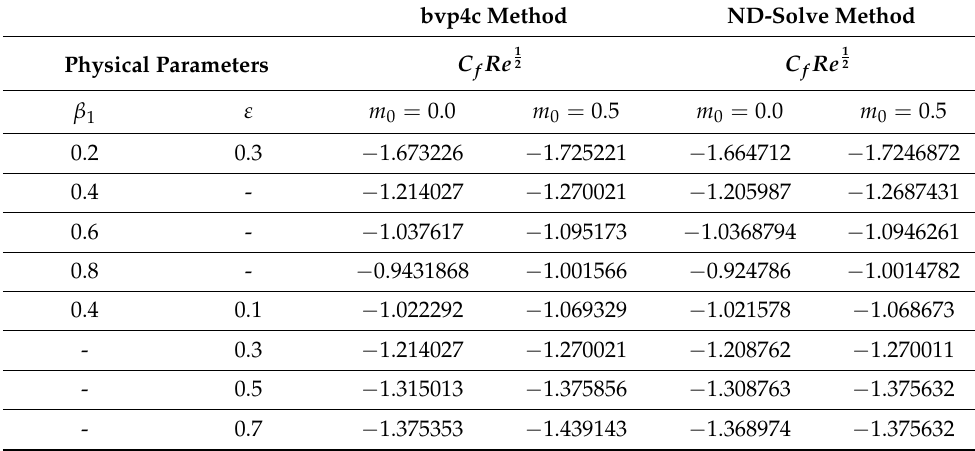
Table 3. Comparison of results with two different techniques (bvp4c and NDsolve) for β 1 and ε while the rest of physical parameters remained fixed.